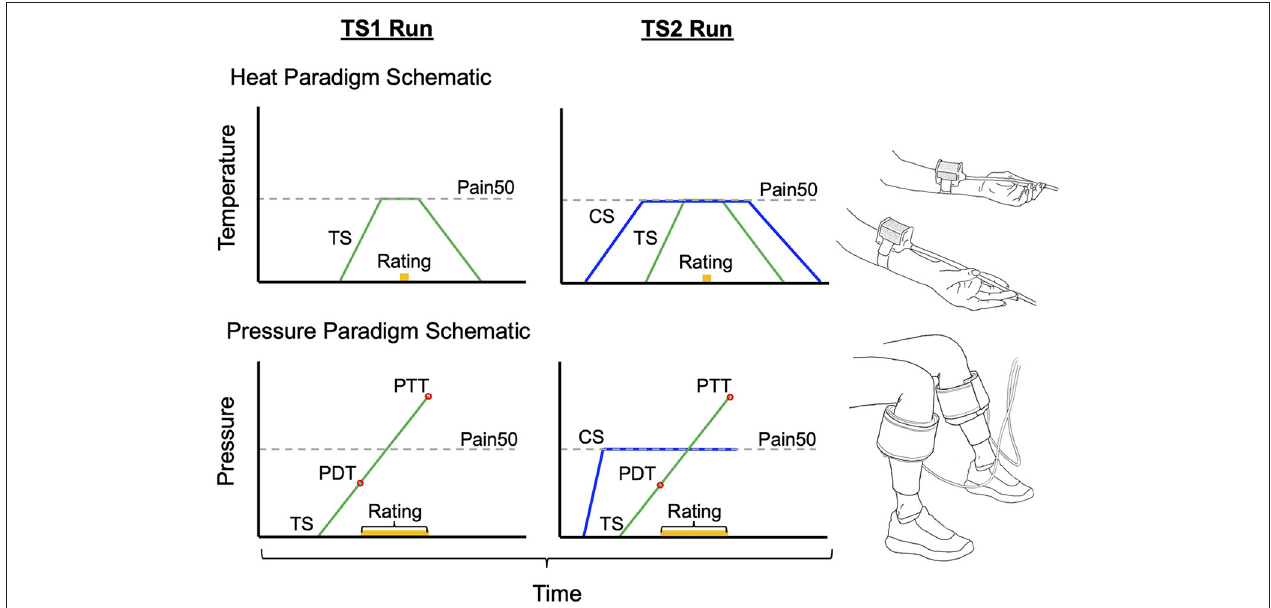
FIGURE 1 | Schematics to represent the stimulus order given in each CPM paradigm and the standard setup. In the heat paradigm the test stimulus (TS) is held at the Pain50 temperature only while the pain rating is obtained. In the pressure paradigm the TS continues to rise after Pain50 until they reach their pain tolerance. However, the pain rating at Pain50 pressure is extracted from TS1 and TS2 in order to calculate CPM similarly to the heat paradigm. Both are parallel sequence paradigms [conditioning stimulus (CS) in blue overlaps with TS2 when the second pain rating is obtained]. Pain50 is the stimulus intensity that evokes a pain rating of 50/100, where 0 is no pain and 100 is the worst pain imaginable. PDT, pain detection threshold; PTT, pain threshold tolerance.